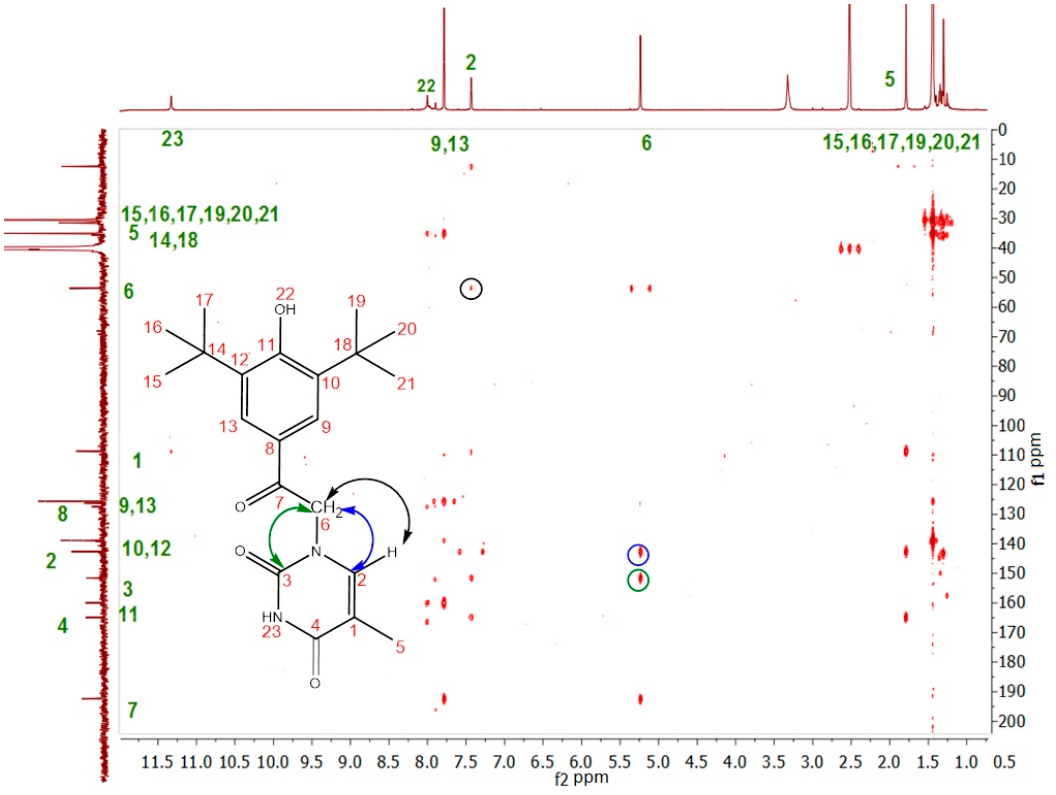
Figure 2. NMR 1 H- 13 C HMBC spectra of Figure 2 . NMR 1 H- 13 C HMBC spectra of 7 .